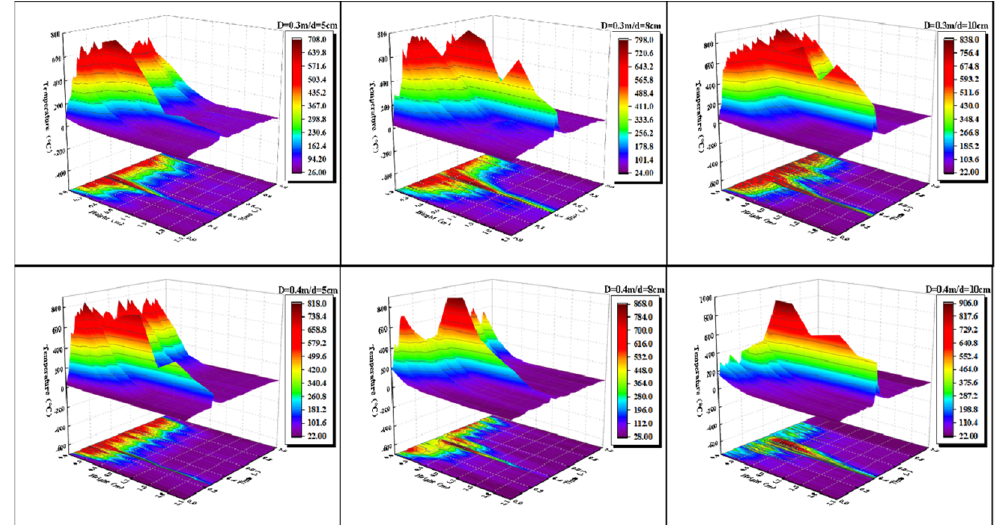
Figure 2. Axial temperature variation of fire plume under different working conditions (Time (-) = T real /T total ).